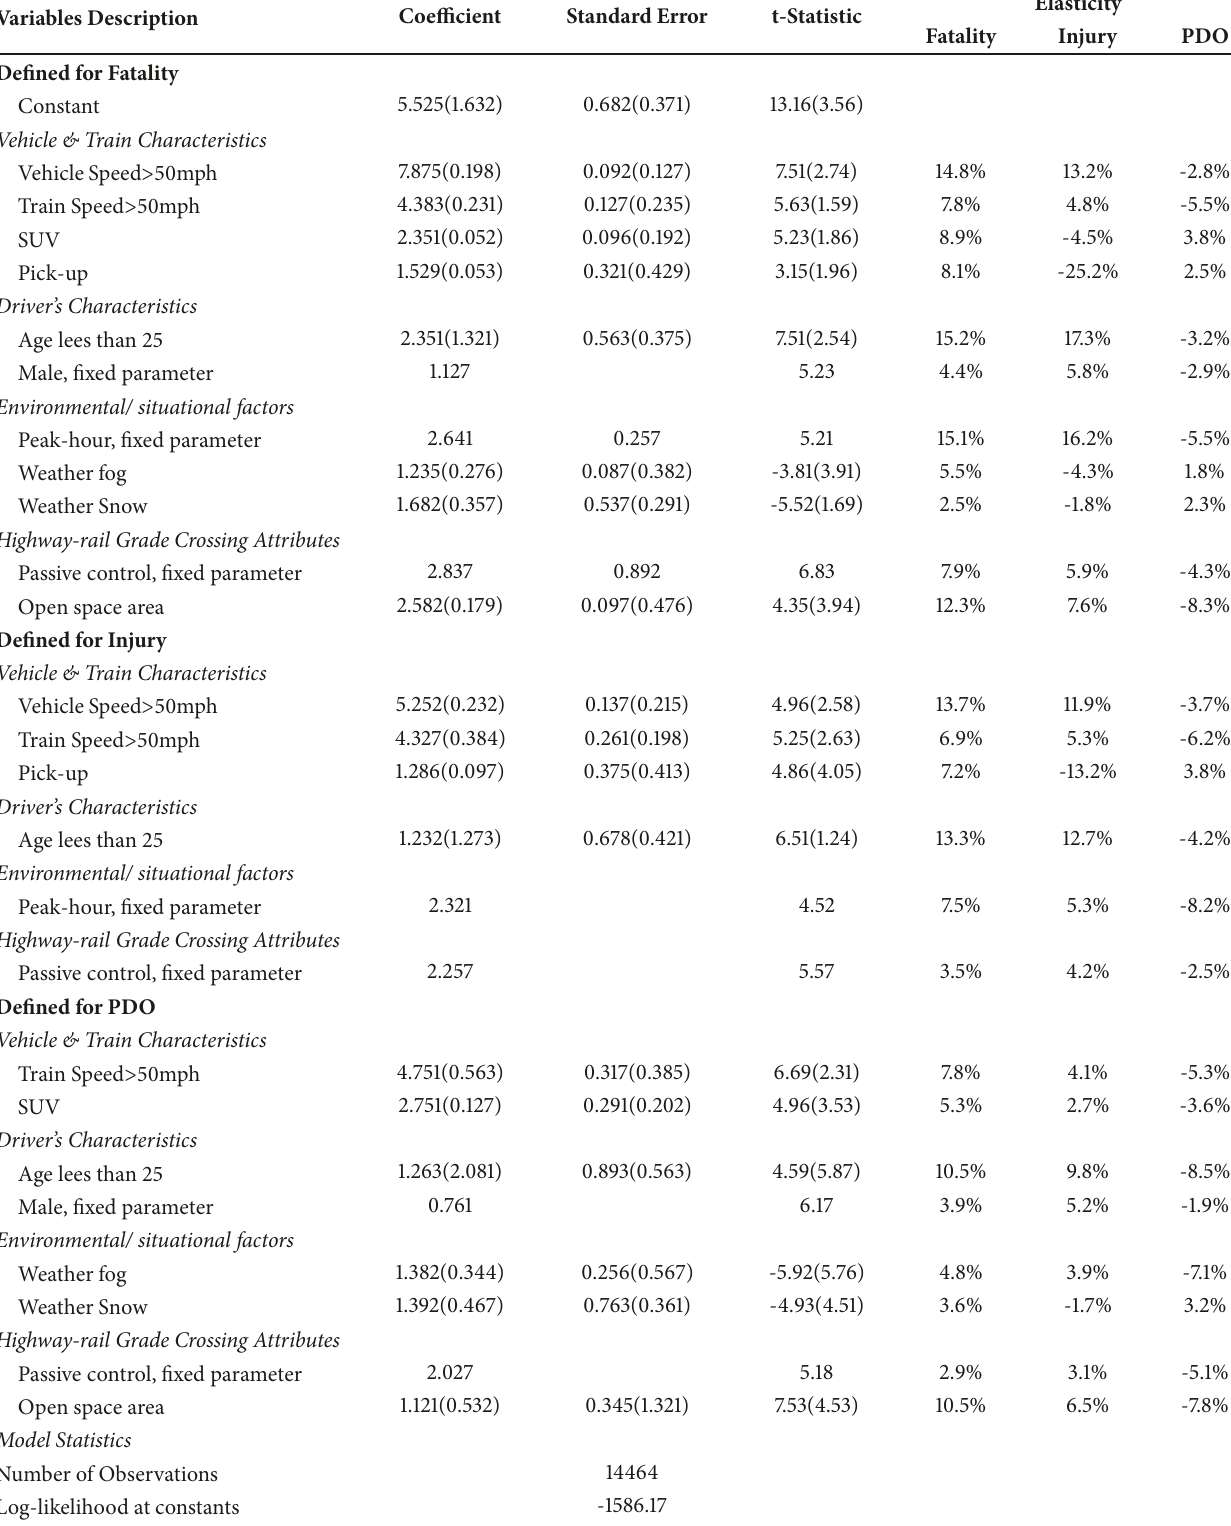
Table 2: Mixed Logit Model Estimation Results for Drivers with Aggressive Driving